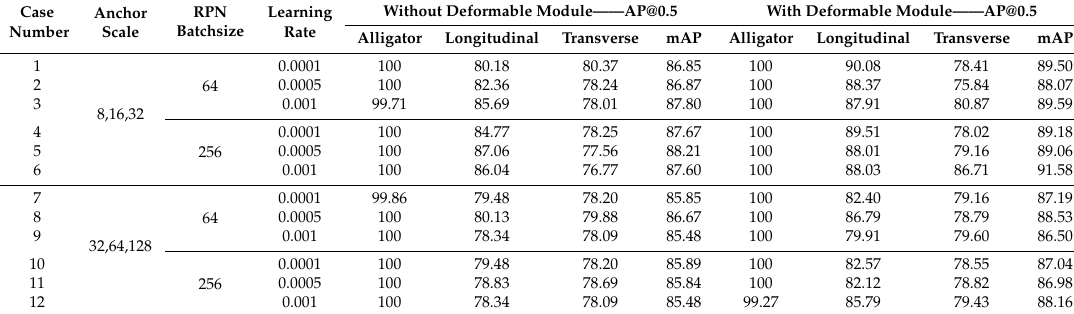
Table 1. Testing Results of Faster R-CNN.